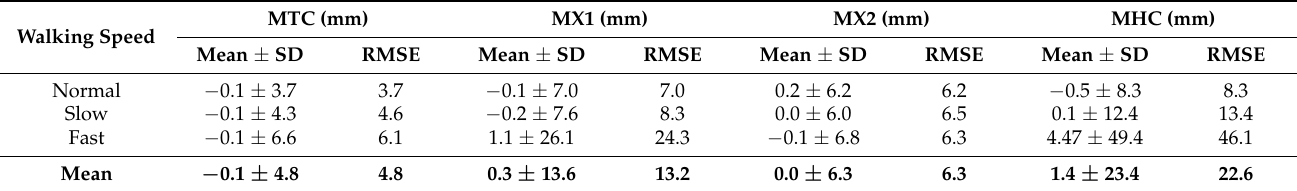
Table 6. The accuracy values of the proposed wearable